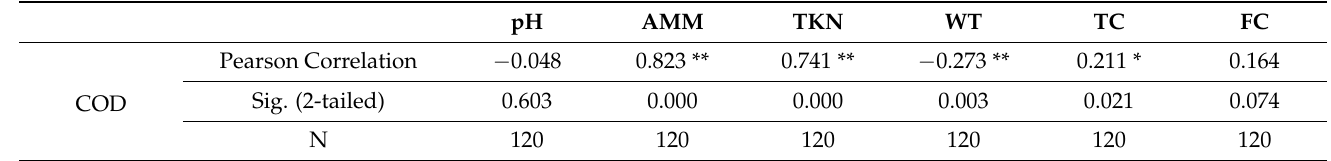
Table 2. Pearson’s correlations between water quality parameters and COD. pH AMM TKN WT TC FC Pearson Correlation − 0.048 0.823 ** 0.741 ** − 0.273 ** 0.211 * 0.164 Sig. (2-tailed) 0.603 0.000 0.000 COD